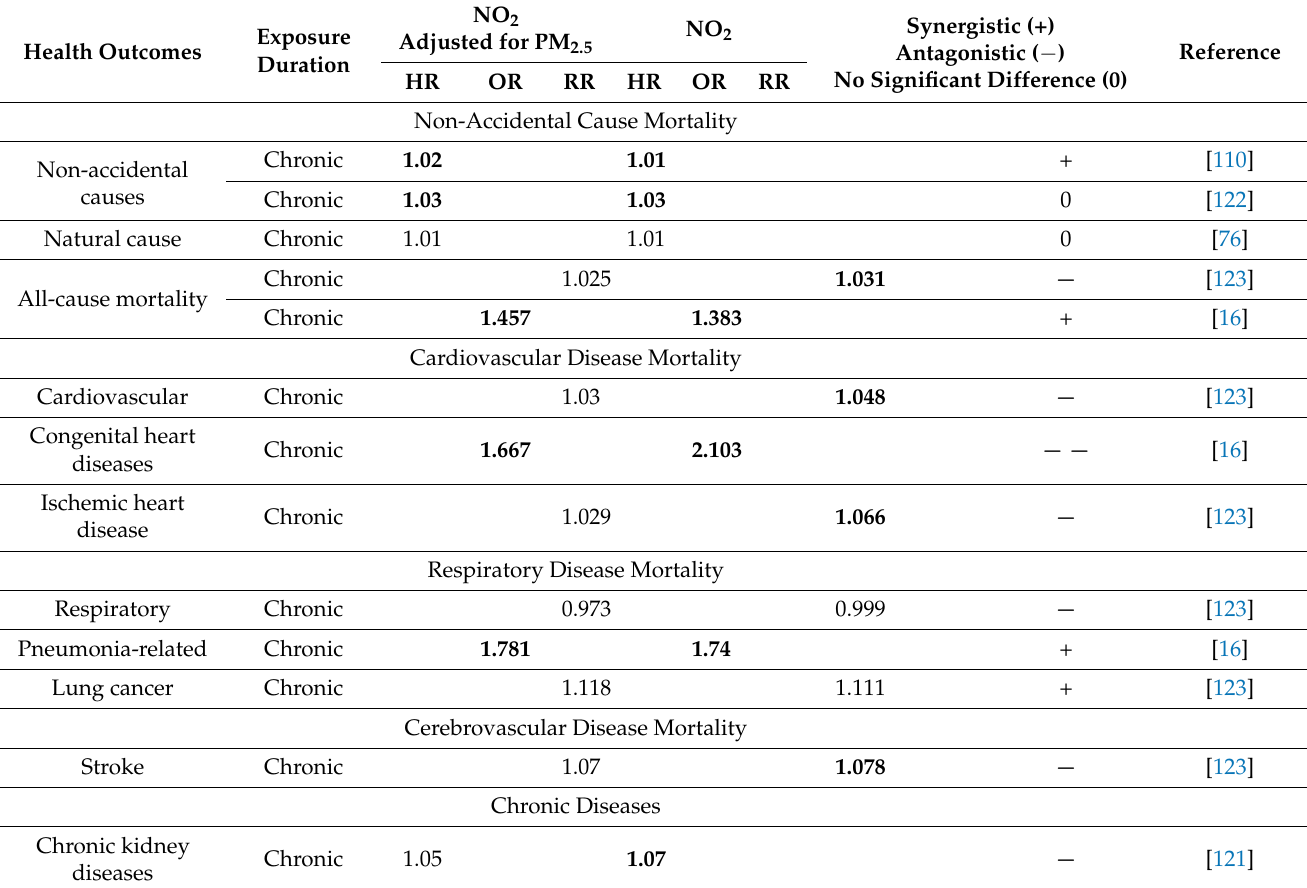
Table 4. Risk ratio (RR), odds ratio (OR), and hazard ratio (HR) with corresponding health effects linked to NO 2 exposure alone and adjusted for PM 2.5